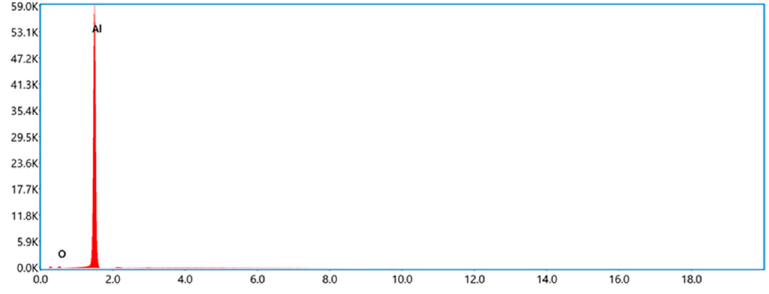
Figure 2. EDS spectrum of Al nanoparticles.